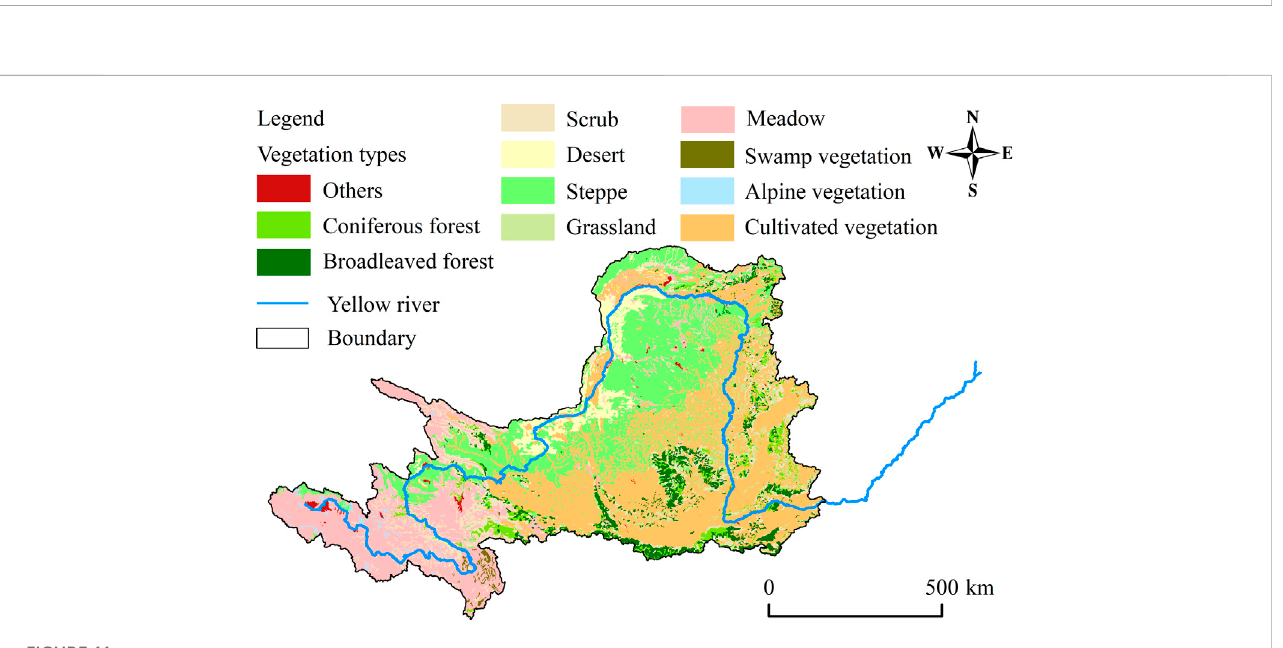
FIGURE 11 Spatial distributions of vegetation types in the